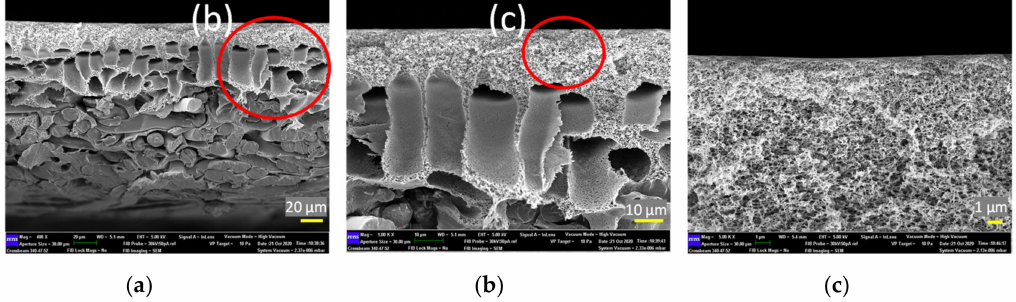
Figure 7. Cross-section structure of control membrane at di ff erent scale bars, ( a ) 20 µ m, ( b ) 10 µ m, and ( c ) 1 µ m (the red circles in the photographs indicate the enlarged area for further